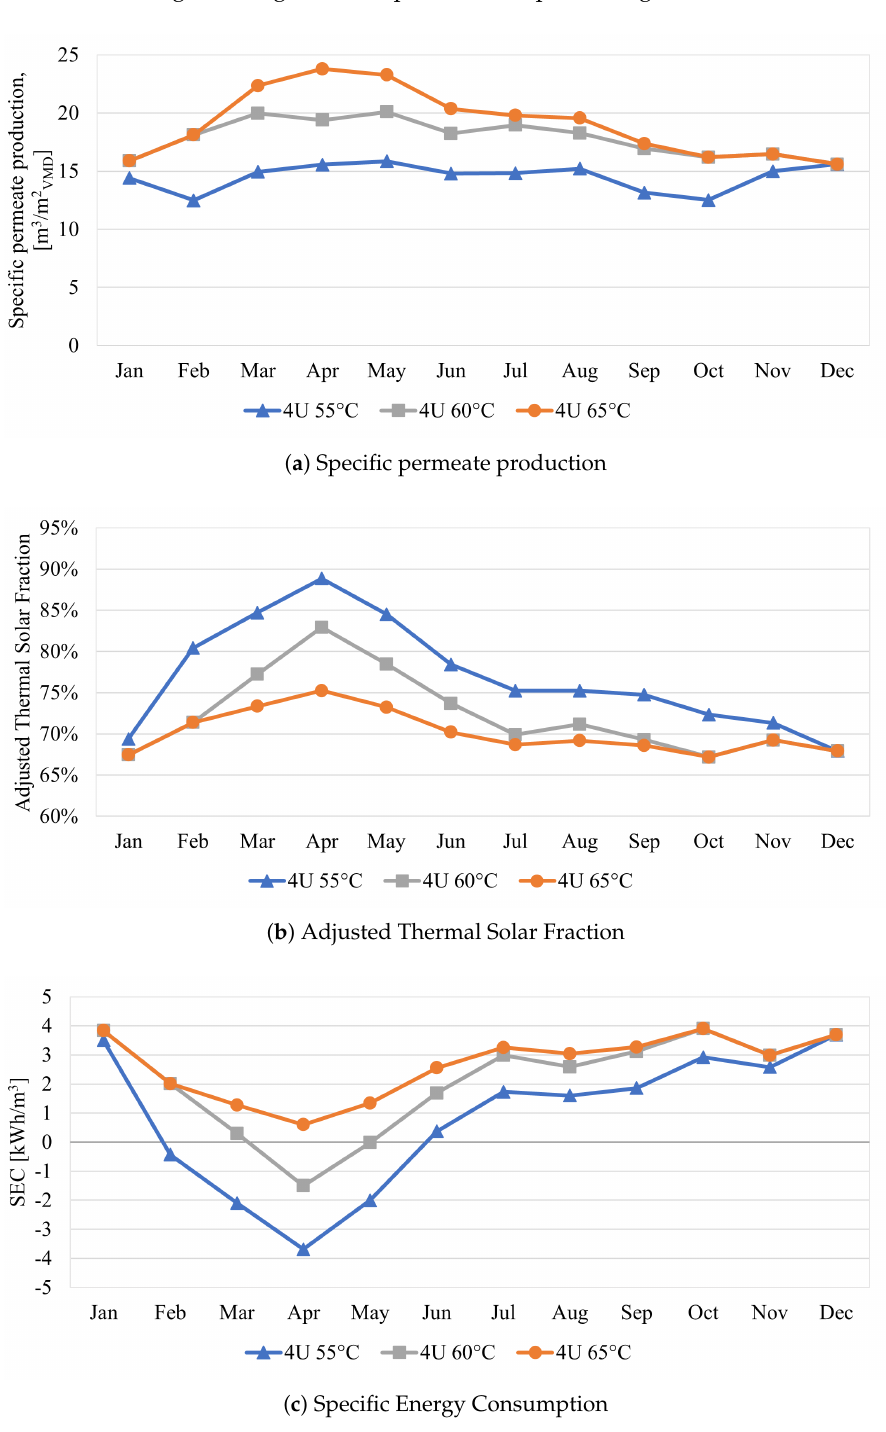
Figure 5. Effect of varying the set point temperature of brine at VMD module entrance. Despite a larger permeate production, a higher brine set point temperature results in a much lower adjusted thermal SF, as presented in Figure 5b. Except for December, where the adjusted thermal SF for any brine set point temperature is the same, the 55 °C scenario showed a better performance for each month, reaching a top SF of 89% during April in comparison to the 83% and 75% peak-adjusted thermal SFs reached by the 60 and 65